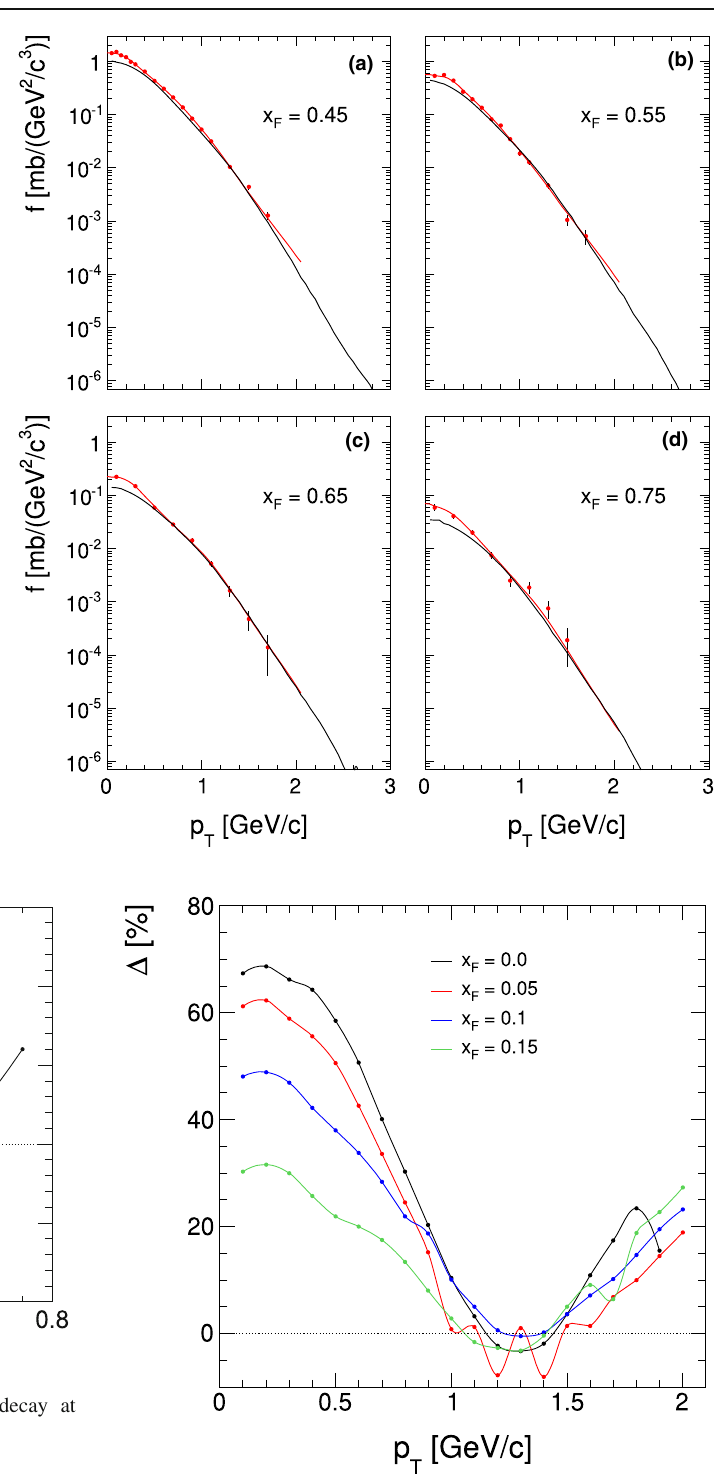
Fig. 187 Percent deviation between data and resonance sum as a func- tion of p T for x F = 0, 0.05, 0.1 and 0.15